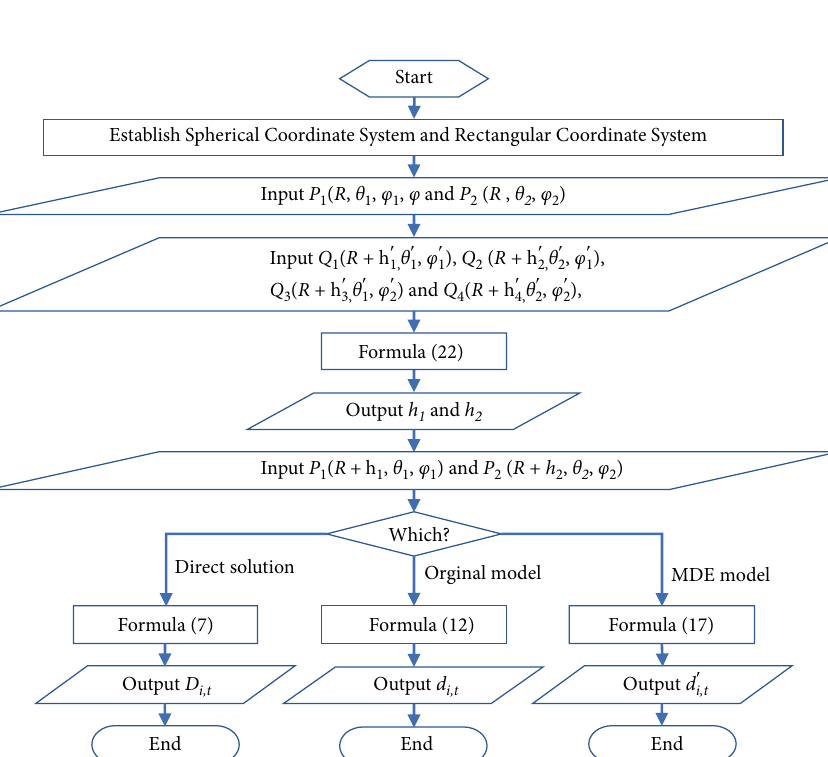
Figure 4: Flow chart of Modified Digital Elevation Model.